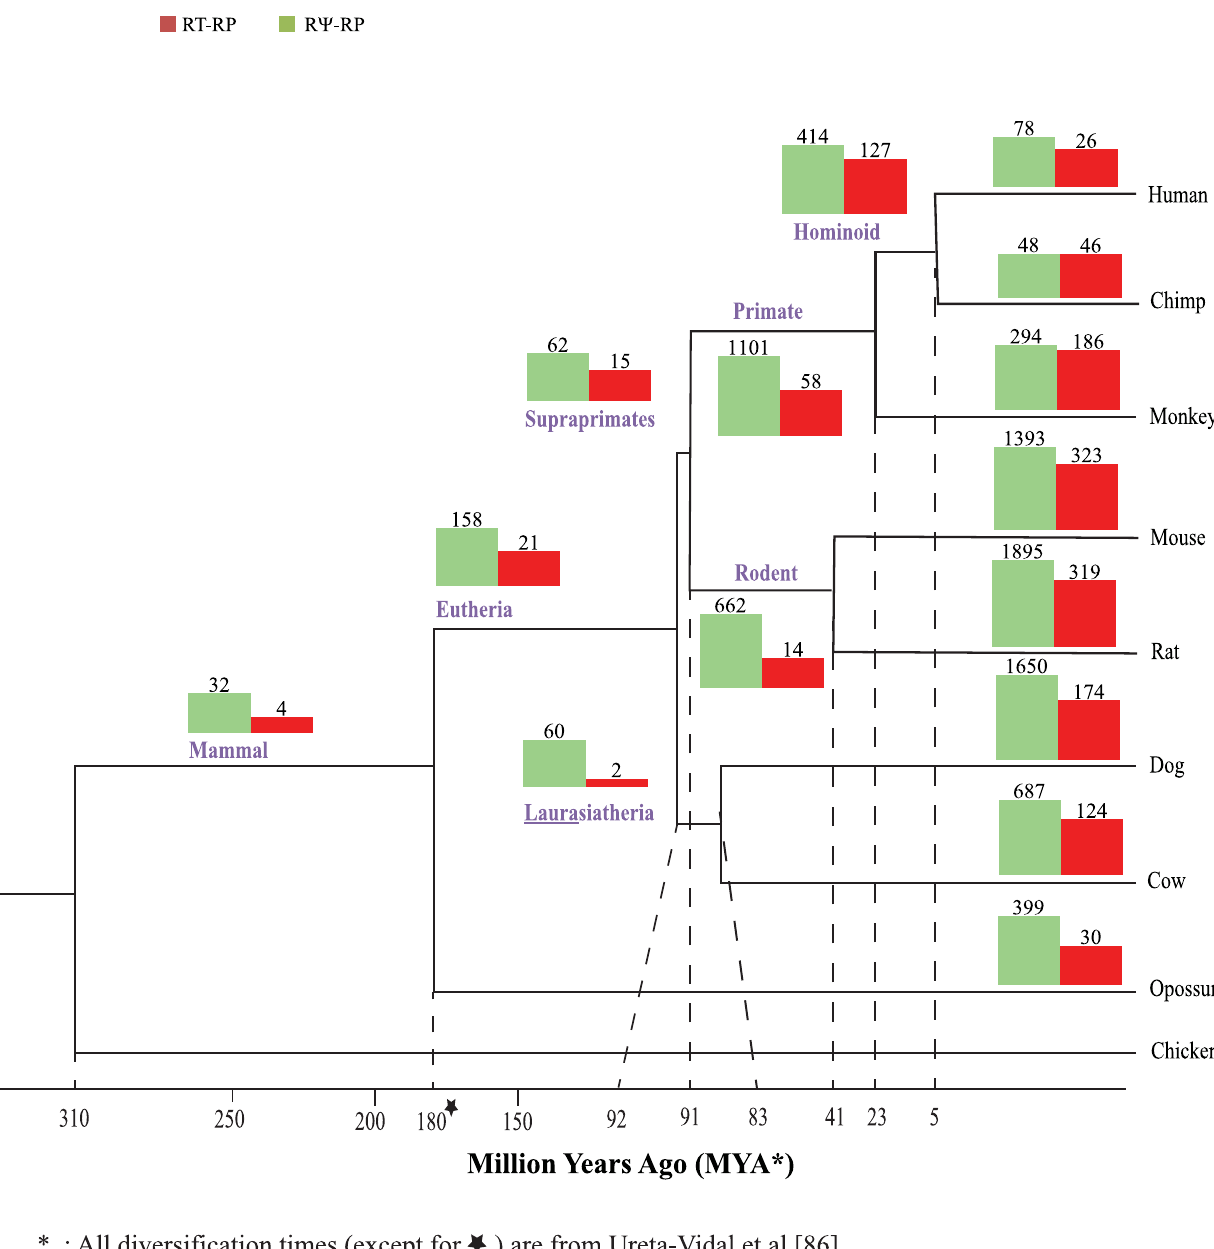
Figure 4. Ribosomal Protein Family duplication events based on age. All RP gene duplication events are displayed for 8 mammalian species. The bar charts at all speciation nodes show events classified by fate of duplication. The duplication counts on the bar charts are log normalized. RT- RPs are shown in red and R Y -RPs in green. DD-RPs are not shown due to a very small sample size. The numbers above the bar charts represent the total number of gene duplication events at that speciation node. Age is marked at the bottom of the tree in millions of years (age estimates from [55,103]). confirm that purifying selection is the predominant force acting in the evolution of ribosomal protein genes. Hence it further validates the Ka/Ks values obtained from both pair-wise and branch-wise methods.